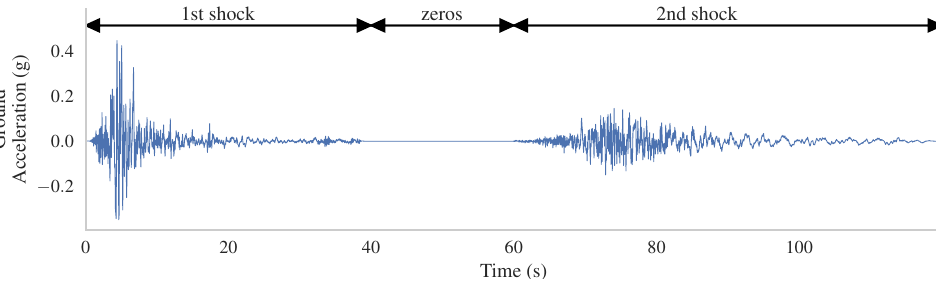
Figure 1. Representative ground motion signal of successive seismic